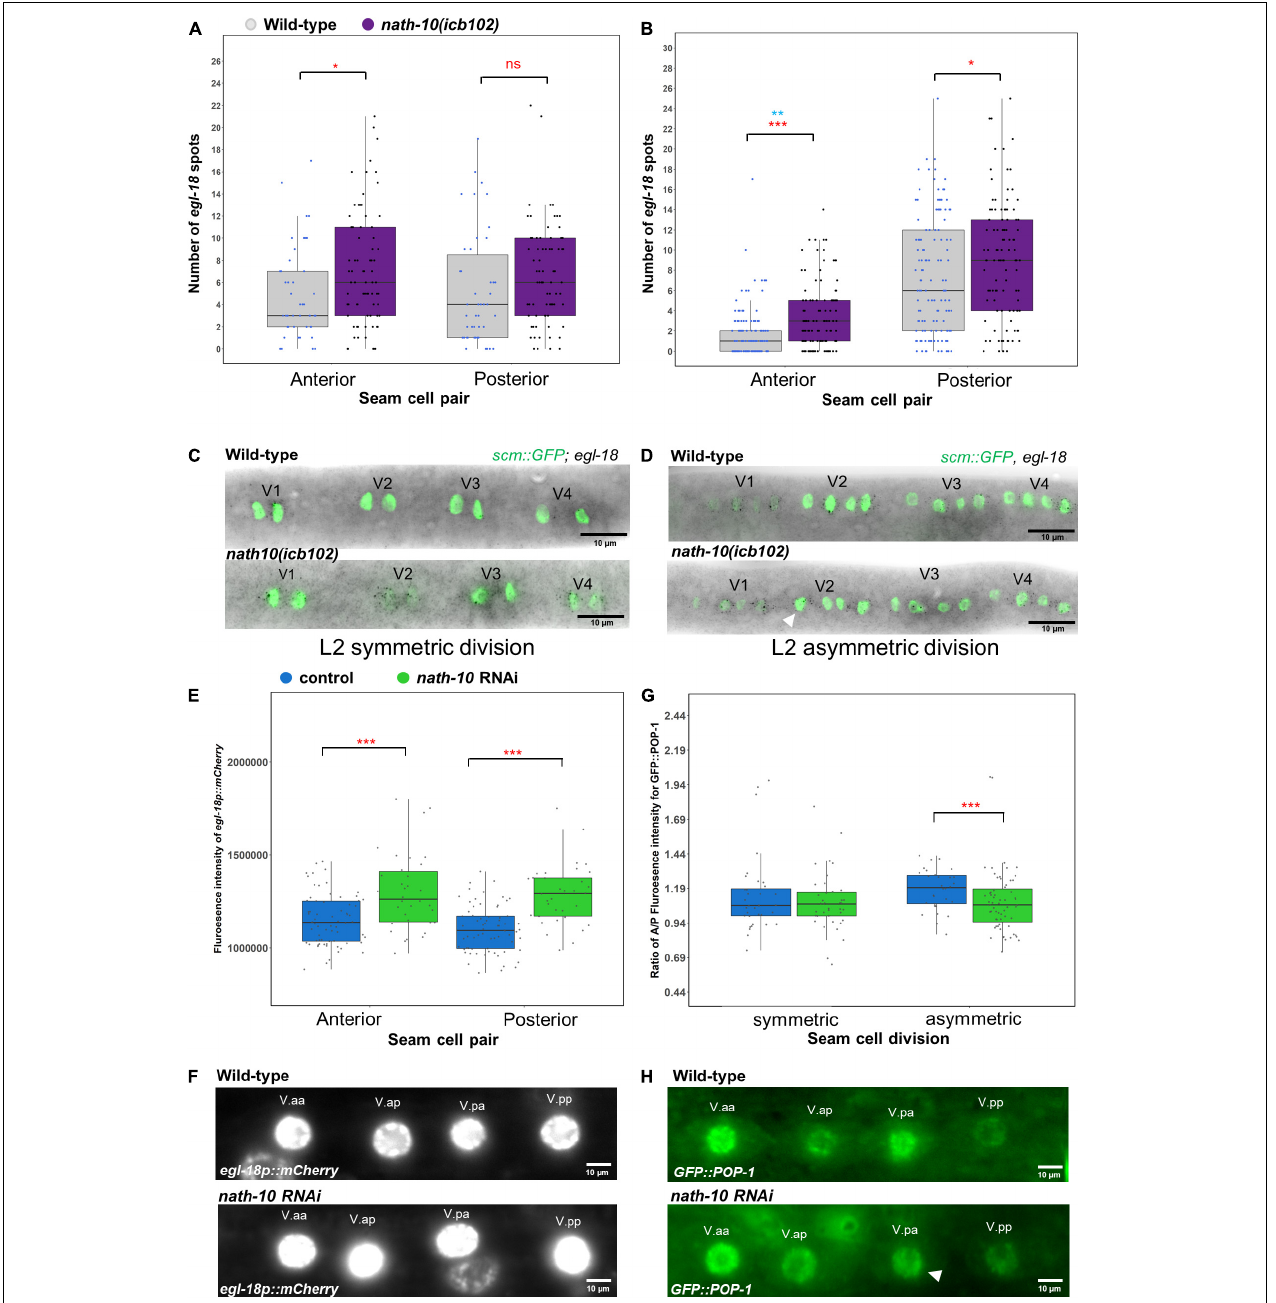
FIGURE 5 | nath-10 loss-of-function leads to changes in Wnt signaling and activation. (A,B) smFISH counts of egl-18 in L2 symmetric (A) and asymmetric (B) cell division of V1-V4 lineage cells in wild type (gray) and nath-10(icb102) (purple). Note that nath-10(icb102) animals show a significant increase in mRNA transcript counts in anterior V lineage daughters [ t -test, * p < 0.05, wild type n = 46, nath-10(icb102) n = 78 cells]. (B) smFISH counts of egl-18 in L2 asymmetric V cell lineage division. Anterior and posterior V lineage cells in nath-10(icb102) show a significant increase in average mRNA count and variability [ t -test, *** p < 0.001 in red, wild type n = 129, nath-10(icb102) n = 106 cells and Levene’s test ** p < 0.01, blue]. (C,D) Representative images of egl-18 smFISH in wild type and nath-10(icb102) animals at L2 symmetric and asymmetric division stage. (E) Quantification of fluorescence intensity from the egl-18::mCherry reporter in the nuclei of V lineage seam cell pairs (V.aa/V.ap and V.pa/V.pp) at the asymmetric L2 division. egl-18::mCherry is significantly increased in the anterior and posterior V lineage seam cell daughters in animals exposed to nath-10 RNAi compared to empty vector control (*** p < 0.001, t -test, wild type n = 69, nath-10 RNAi n = 34). (F) Representative images for egl-18p::mCherry in seam cell nuclei pairs (V.aa/V.ap and V.pa/V.pp) at L2 asymmetric division stages for nath-10 RNAi exposed animals and empty vector control. (G) Quantification of anterior/posterior cell ratio of GFP::POP-1 at the symmetric and asymmetric L2 division in V lineage seam cell pairs (V.aa/V.ap and V.pa/V.pp). A significant decrease in this ratio was found when animals were exposed to nath-10 RNAi (*** p < 0.001, t -test). (H) Representative GFP::POP-1 images in control and nath-10 RNAi animals, arrowhead indicates representative anterior V lineage cell with lower expression of GFP::POP-1 (wild type n = 31, nath-10 RNAi n = 65).